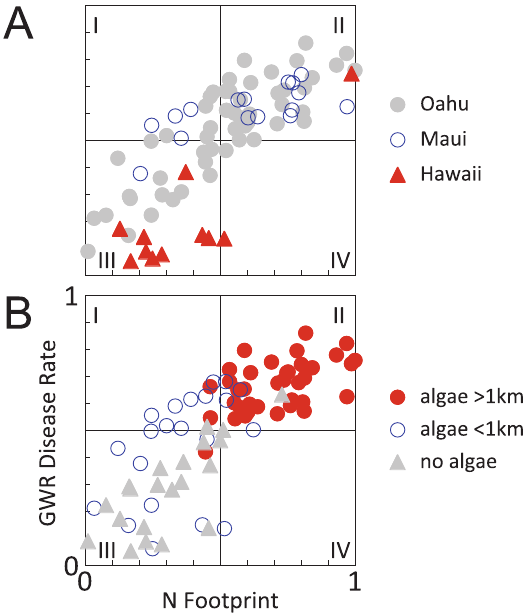
Figure 5. Invasive macroalgae are chronically widespread in watersheds where disease rates and Nitrogen-footprint values are elevated. A , GWR predicted disease rates and Nitrogen-footprints grouped by island. Oahu points are clustered (87%, 48/55) in quadrants II and III, on Maui points are clustered in quadrants I and II (94%, 15/16), and Hawaii points are clustered in quadrant III (82%, 9/11). B , Disease and Nitrogen-footprints are elevated where macroalgae is chronic and widespread, seen as most points are in quadrant II (88%, 35/40). Green turtles now consume nonnative macroalgae which likely sequester environmental N as arginine. Arginine is known to regulate herpesvi- ruses and contribute to tumor formation.